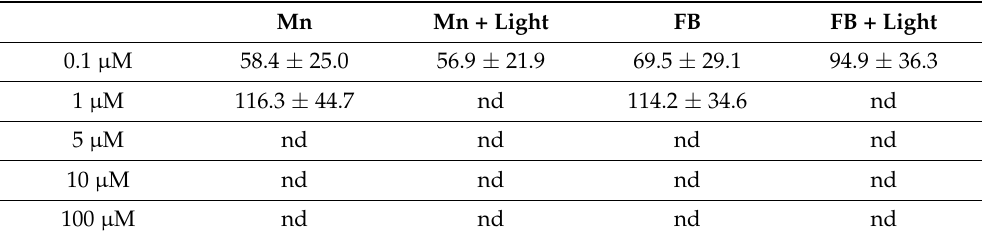
Table 3. Time required to double the population of the CCD 841 CoTr cells (h) in different conditions of incubation: porphyrin (Mn, FB), their concentration and light induction/light absence. The doubling time (DT) for CCD 841 CoTr cells used as a control was 30.1 h. Statistical significance was analyzed at p < 0.05.